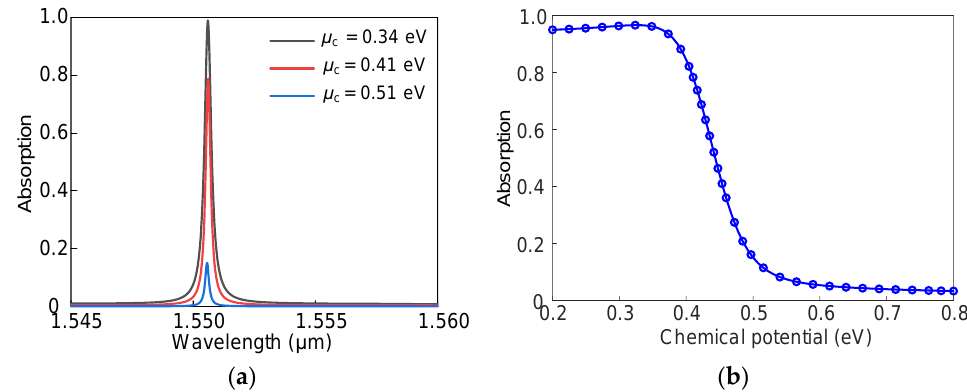
Figure 5. ( a ) Absorption spectra of designed structures under different chemical potentials μ c . ( b ) Effect of chemical potential μ c on the absorption efficiency at 1550.6 nm.